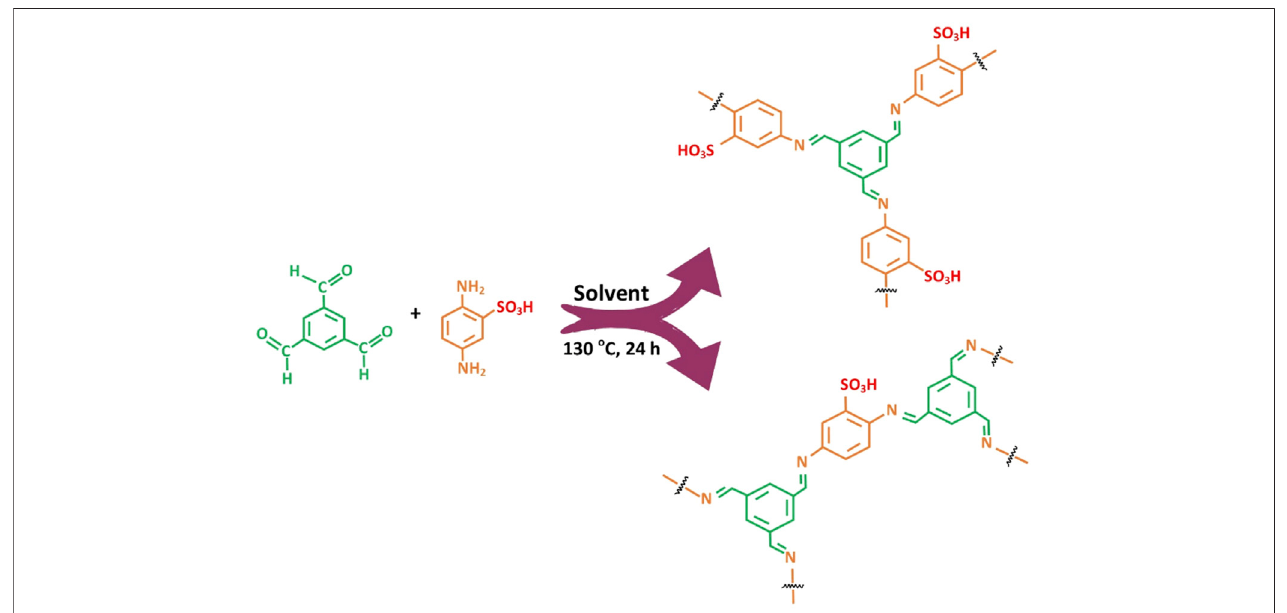
FIGURE 1 | Synthesis of organic polymers with two possible repeating units.